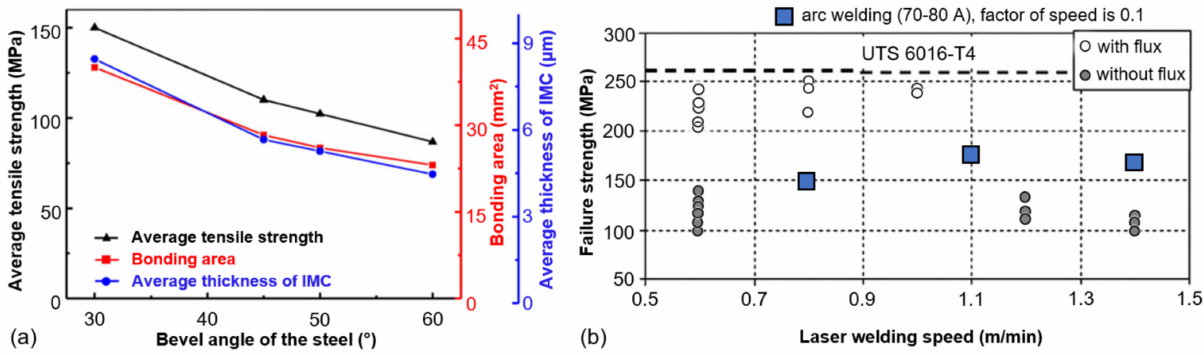
Figure 16. ( a ) Effect of bevelling angle on IMC and wetting distance (bonding area) and its effect on tensile strength of Fe-Al joint. Modified from Sun et al. [46]. ( b ) Effect of flux prior to welding on galvanised steel and comparison with arc welding results. Modified from Sierra et al.